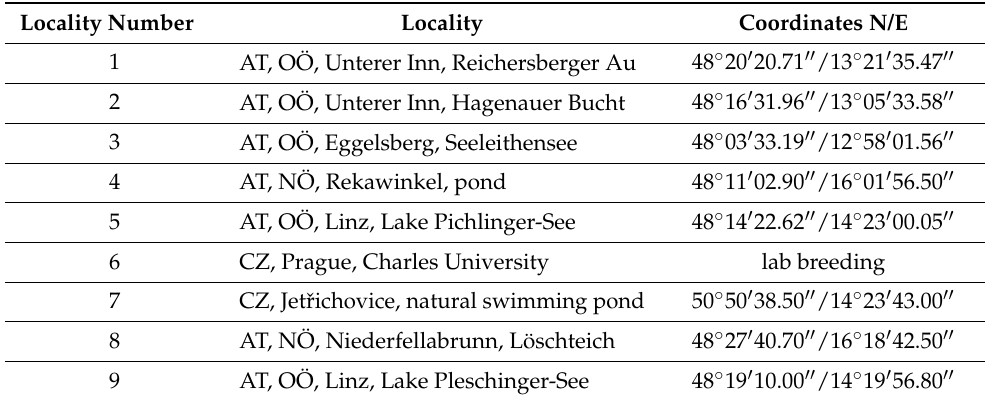
Table 1. List of locations where host snails and eDNA samples were collected for the present study. Locality